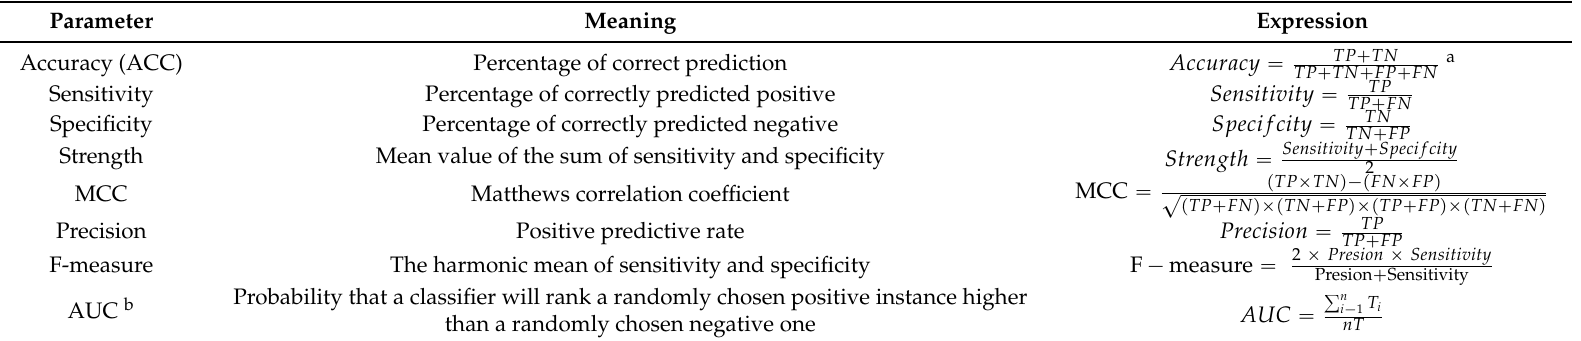
Table 3. Evaluation